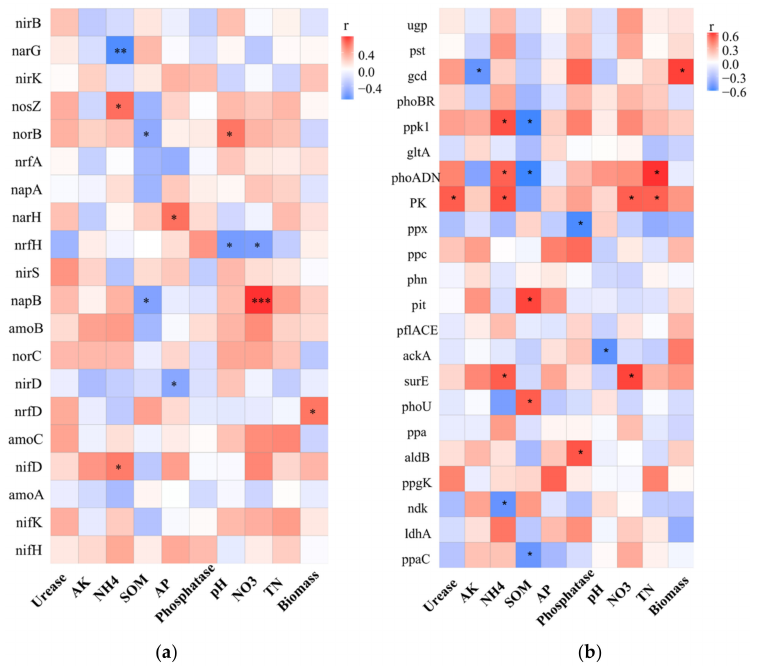
Figure 5. Spearman correlation coefficients between relative abundance of genes related to N metabolism ( a ) and P metabolism ( b ), * 0.01 < p ≤ 0.05, ** p ≤ 0.01, *** p ≤